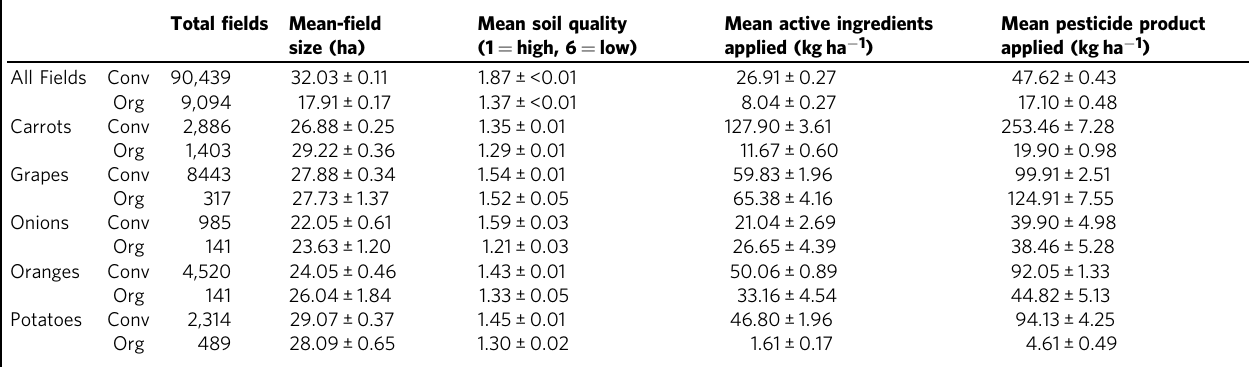
Table 1 Summary statistics for organic and conventional fi